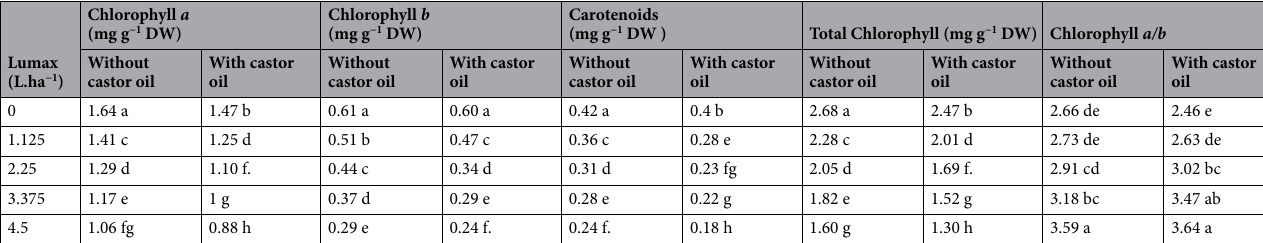
Table 2. The photosynthetic pigment of Solanum nigrum plants in response to different doses of Lumx with and without castor oil. Each value is the mean of four replicates. Means with the same letter within each trait are not significantly different at p < 0.01.